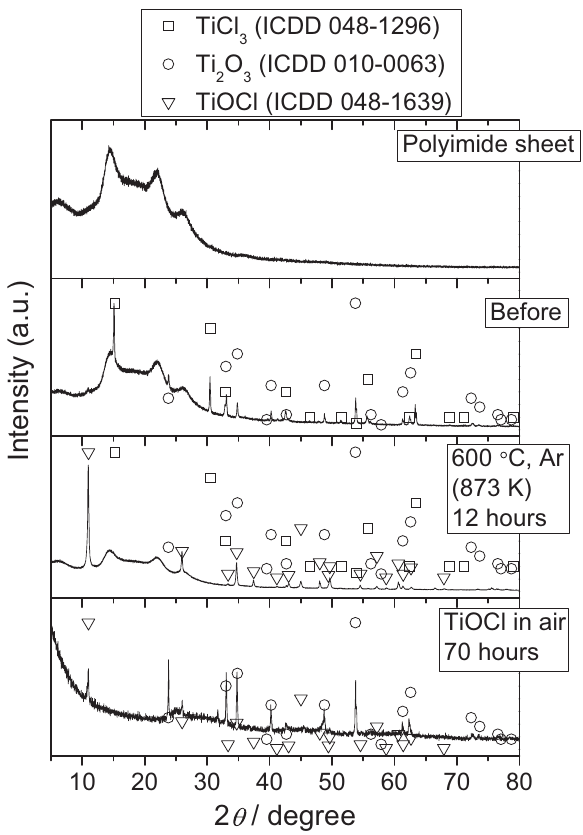
Figure 9. X-ray diffraction pattern of the mixture of TiCl 3 and Ti 2 O 3 before and after